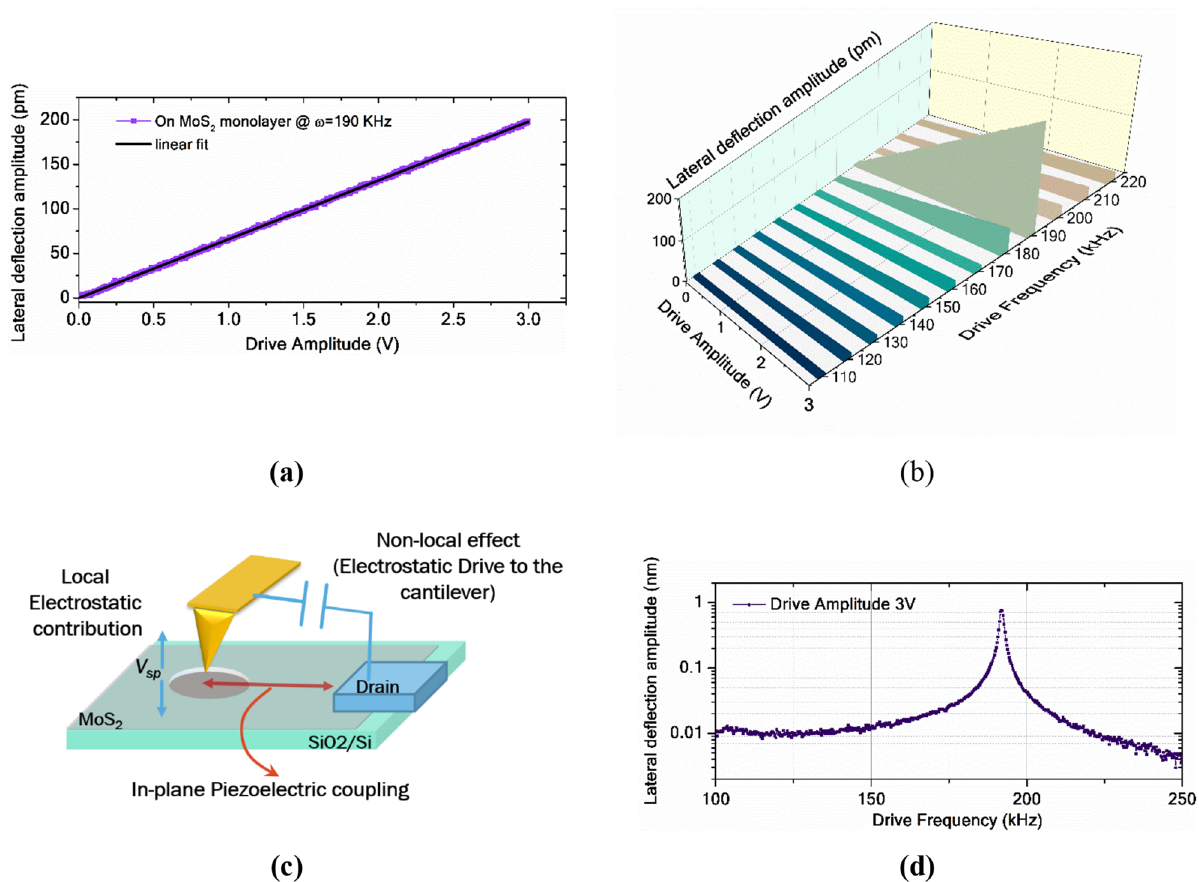
Figure 3. ( a ) Piezoelectric response measured close to contact resonance of the cantilever. ( b ) Lateral piezo response as the frequency of measurement is varied around the contact resonance frequency. ( c ) Schematic showing various contributions to the signal measured (Dimensions are not to the scale). ( d ) Lateral piezoelectric response on 1L-MoS 2 observed at variable drive frequencies at constant ac